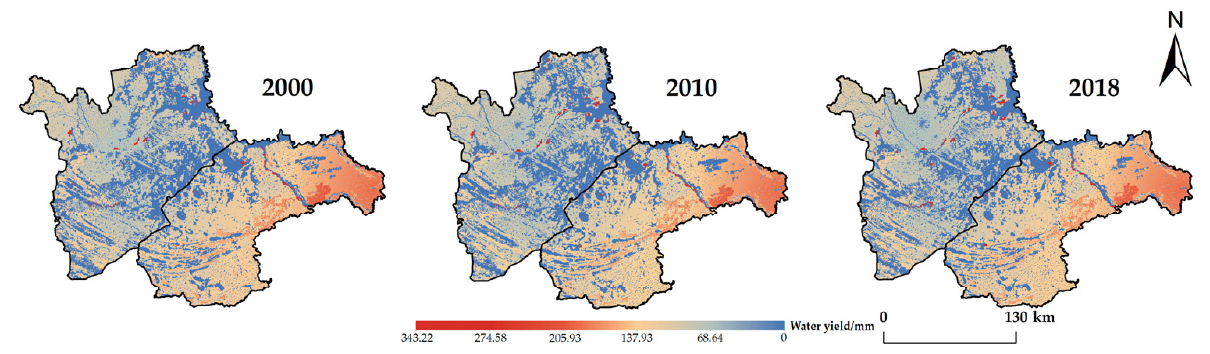
Figure 3. Spatial variation map of water yield in western Jilin. Table 4. Quantification of water supply and demand in western Jilin (10 8 m 3 ).